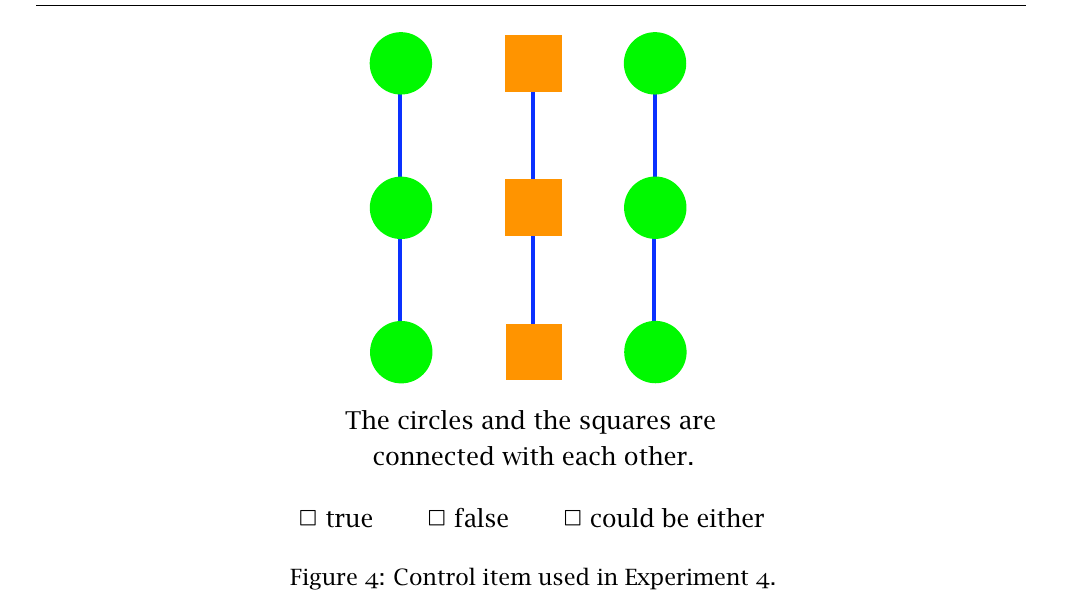
Figure 4 : Control item used in Experiment 4